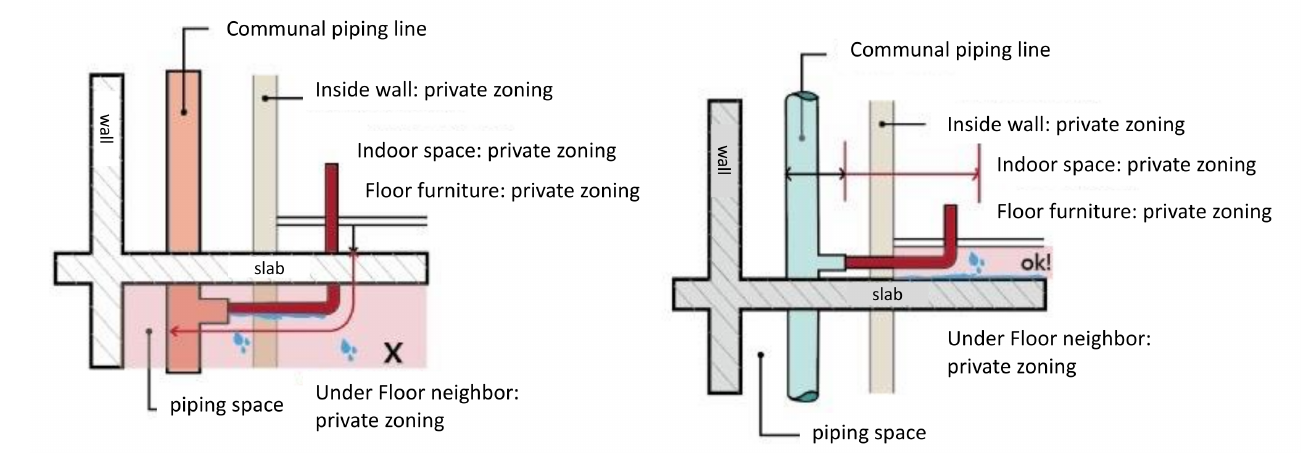
Figure 1. Schematic definition diagram of residential property zoning.